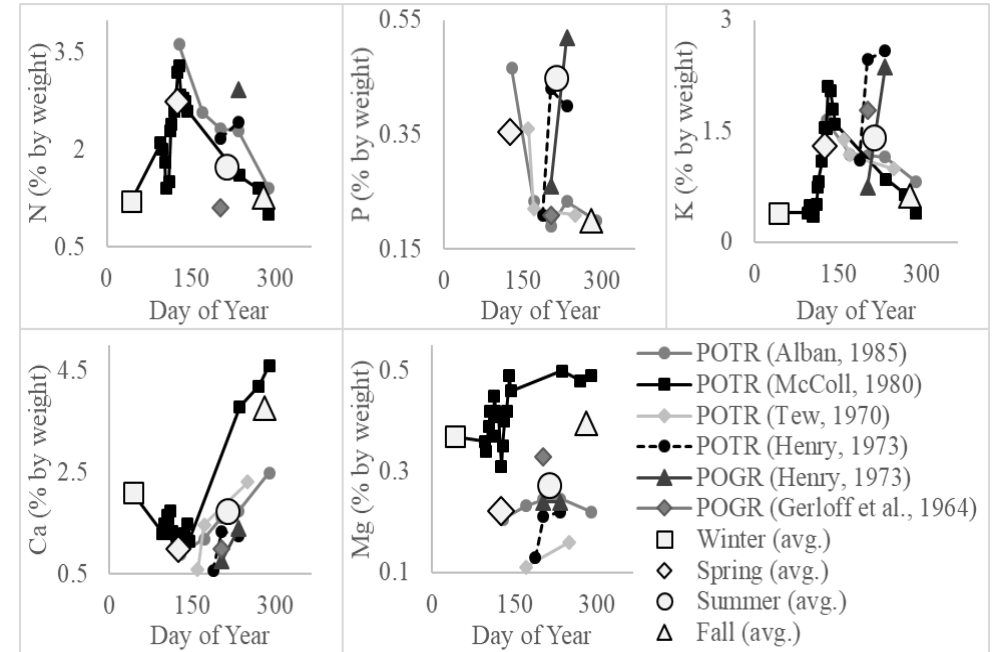
Figure A3. Seasonal foliar macro-nutrient concentrations by day of the year observed in aspen, as well as the average of the seasonal averages across studies (Derived from [13,46–49]) N, P, and K show increases during the growing season while decreasing during the dormant season, with Ca and Mg showing the opposite pattern. Trembling aspen ( Populus tremuloides ) is represented by POTR, and bigtooth aspen ( Populus grandidentata ) is represented by POGR.